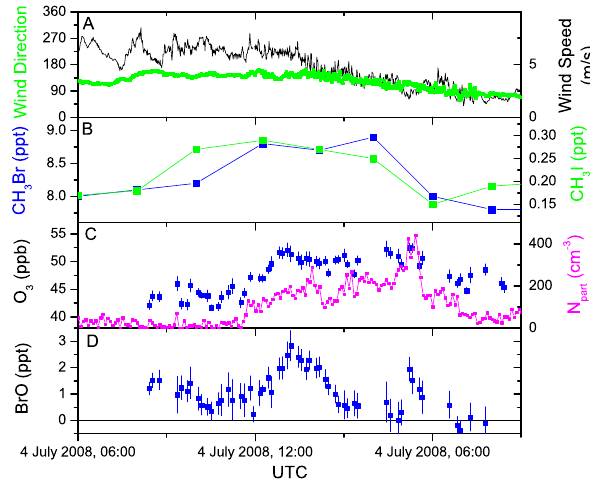
Fig. 9. Example case of a marine airmass, as indicated by the FLEXPART retroplume, arriving at Summit at 12:00UTC on 4 July 2008. Wind direction and speed (A) showed a slow turn from 120 ◦ to 80 ◦ and a slow decrease, respectively. CH 3 Br and CH 3 I (B) as well as particle number and ozone (C) were increased from noon to 18:00UTC compared to their morning levels. BrO mixing ratios (D) showed an simultaneous increase from 0–1ppt in the morning to a maximum of 2.8 ± 0.6ppt at